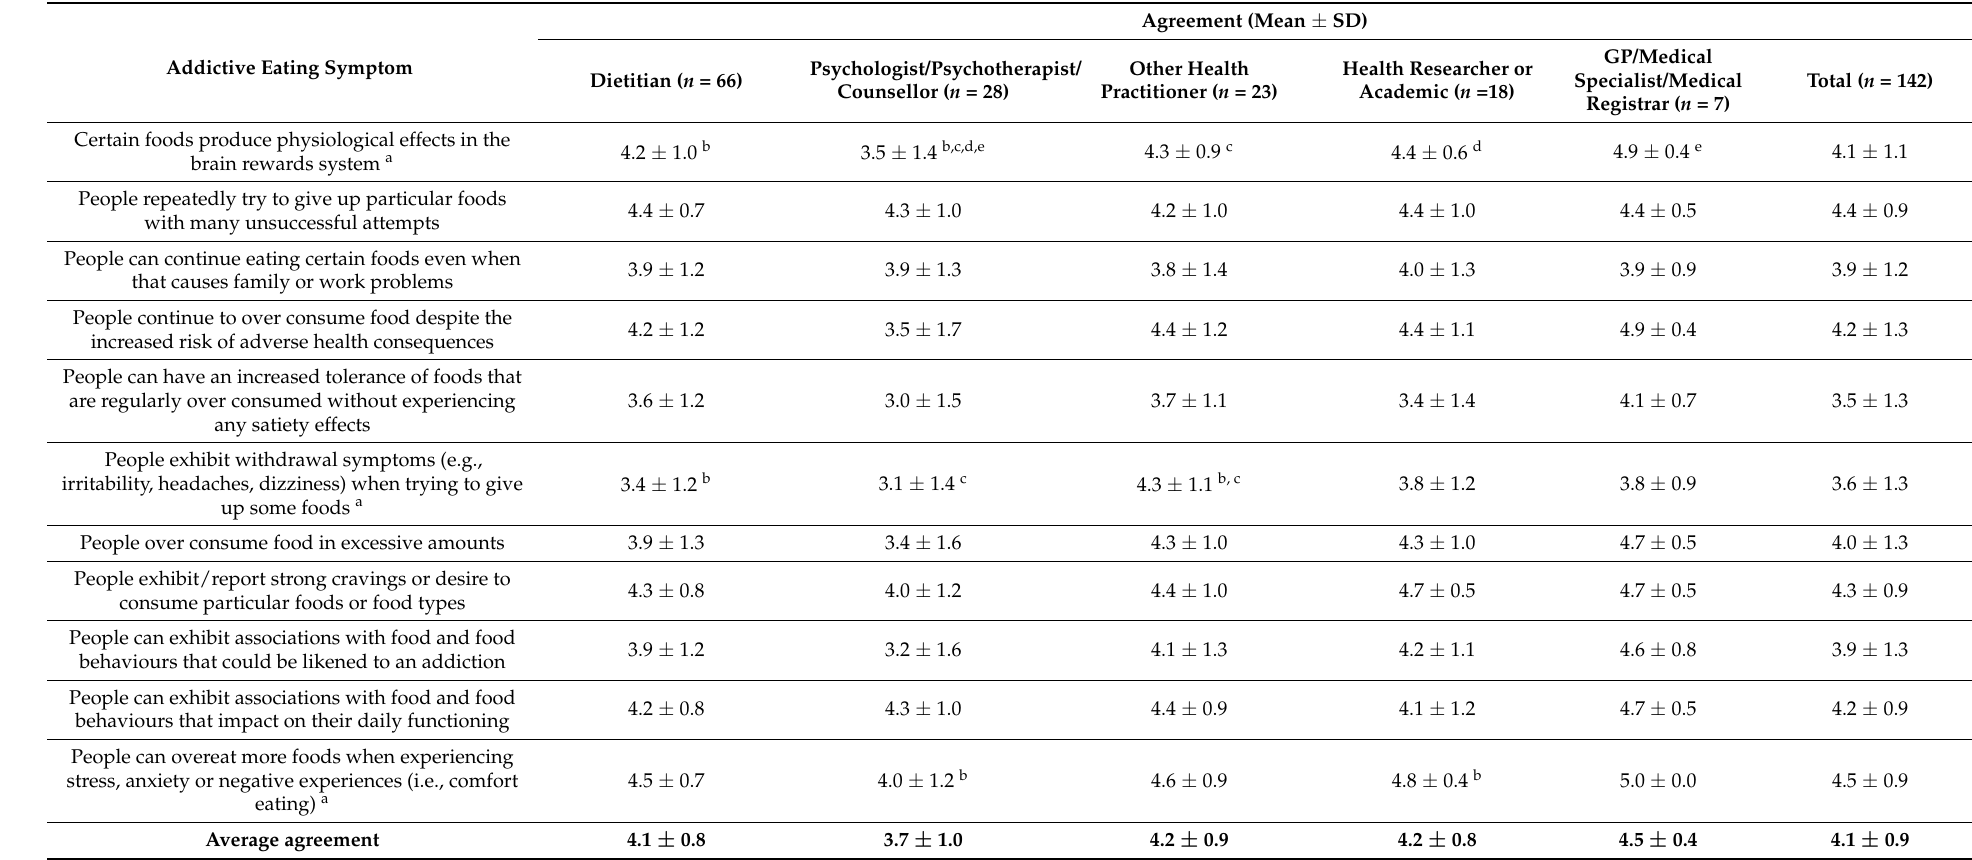
Table 2. Agreement with addictive eating symptoms by health